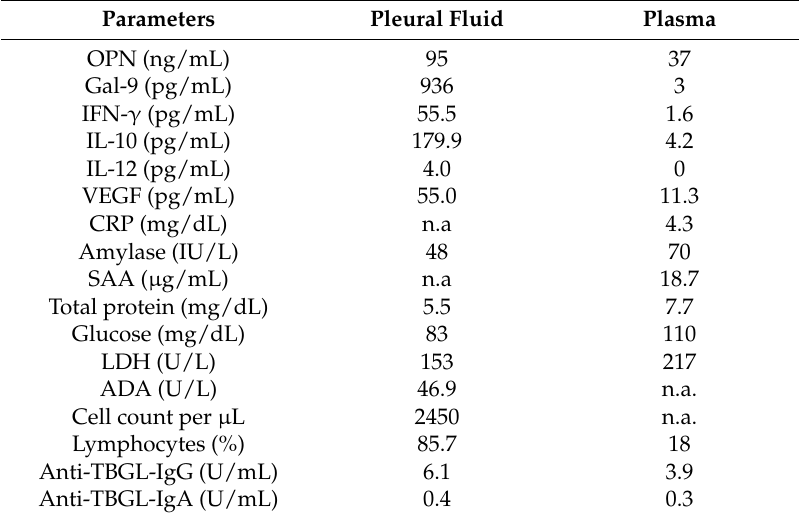
Table 1. Immune characteristics of pleural fluid and